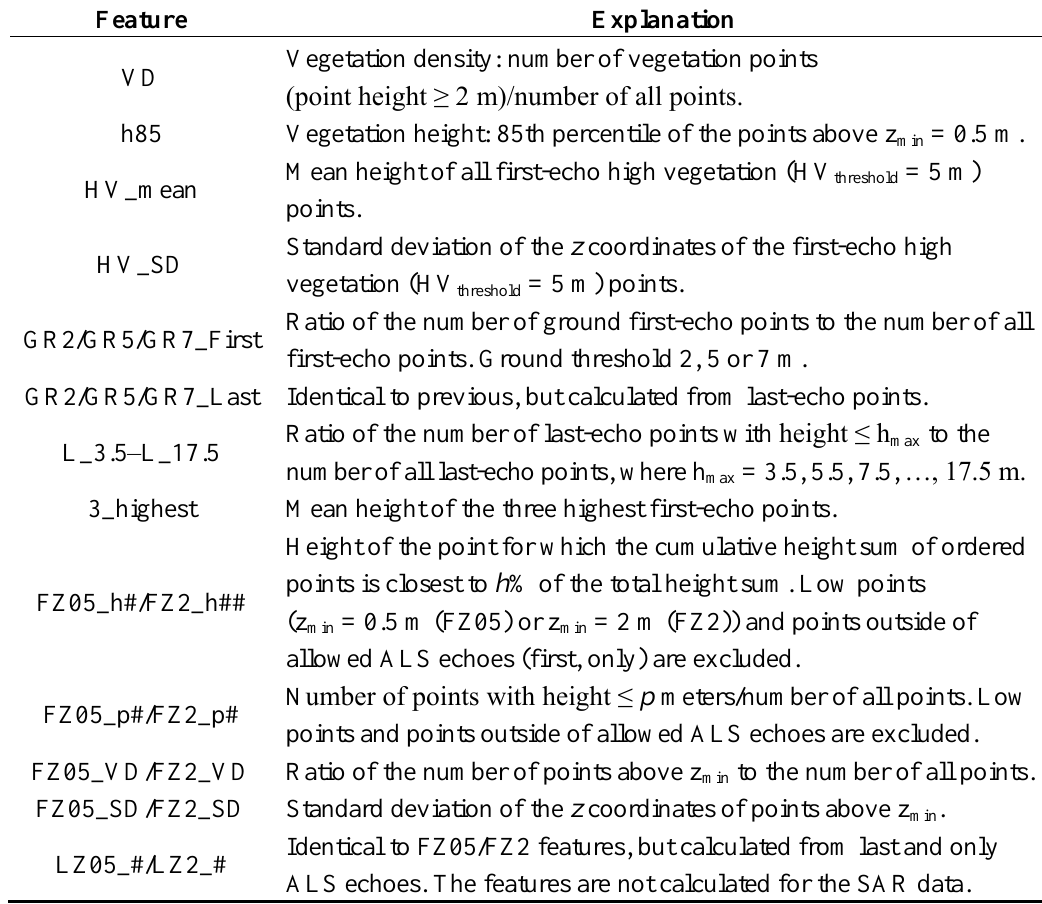
Table A2. Abbreviations for ALS and SAR